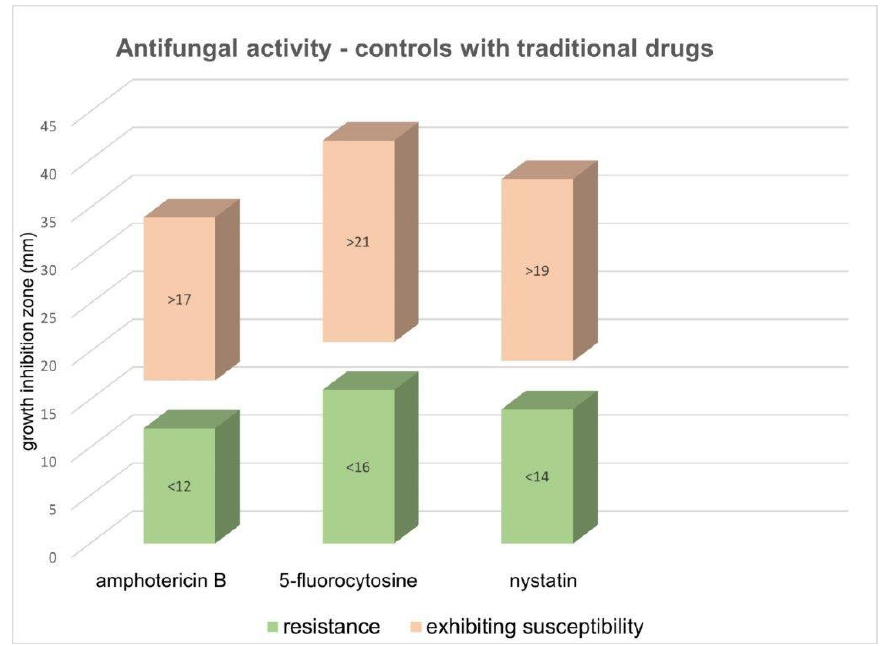
Figure 3. Antifungal activity of controls with traditional drugs for C. albicans . The results are expressed as growth inhibition for three antifungal drugs. Table 2. The results of the antifungal activity of the examined compounds from P. bellus (growth inhibition zone (mm) ± standard deviation).